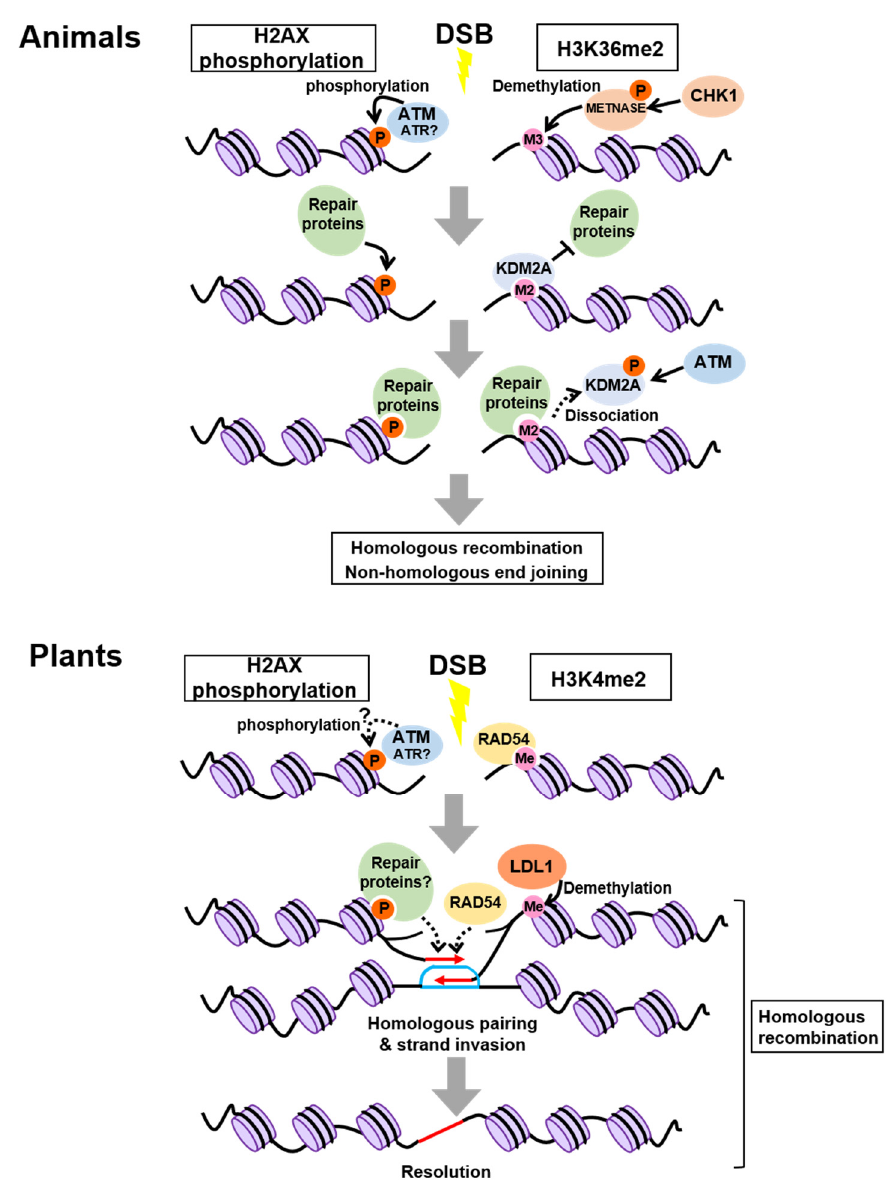
Figure 1. Chromatin modifications involved in homologous recombination and nonhomologous end joining. In animals, ATM is known to phosphorylate H2AX, whereas the involvement of ATR has not been reported so far. In plants, it remains unknown whether H2AX is phosphorylated by ATM or ATR, and whether H3K4 di-methylation is enhanced specifically around damaged sites. M2 and M3 represent H3K36 di- and tri-methylation, respectively. Red and blue lines represent RAD51-bound ssDNA and the captured homologous sequence, respectively.